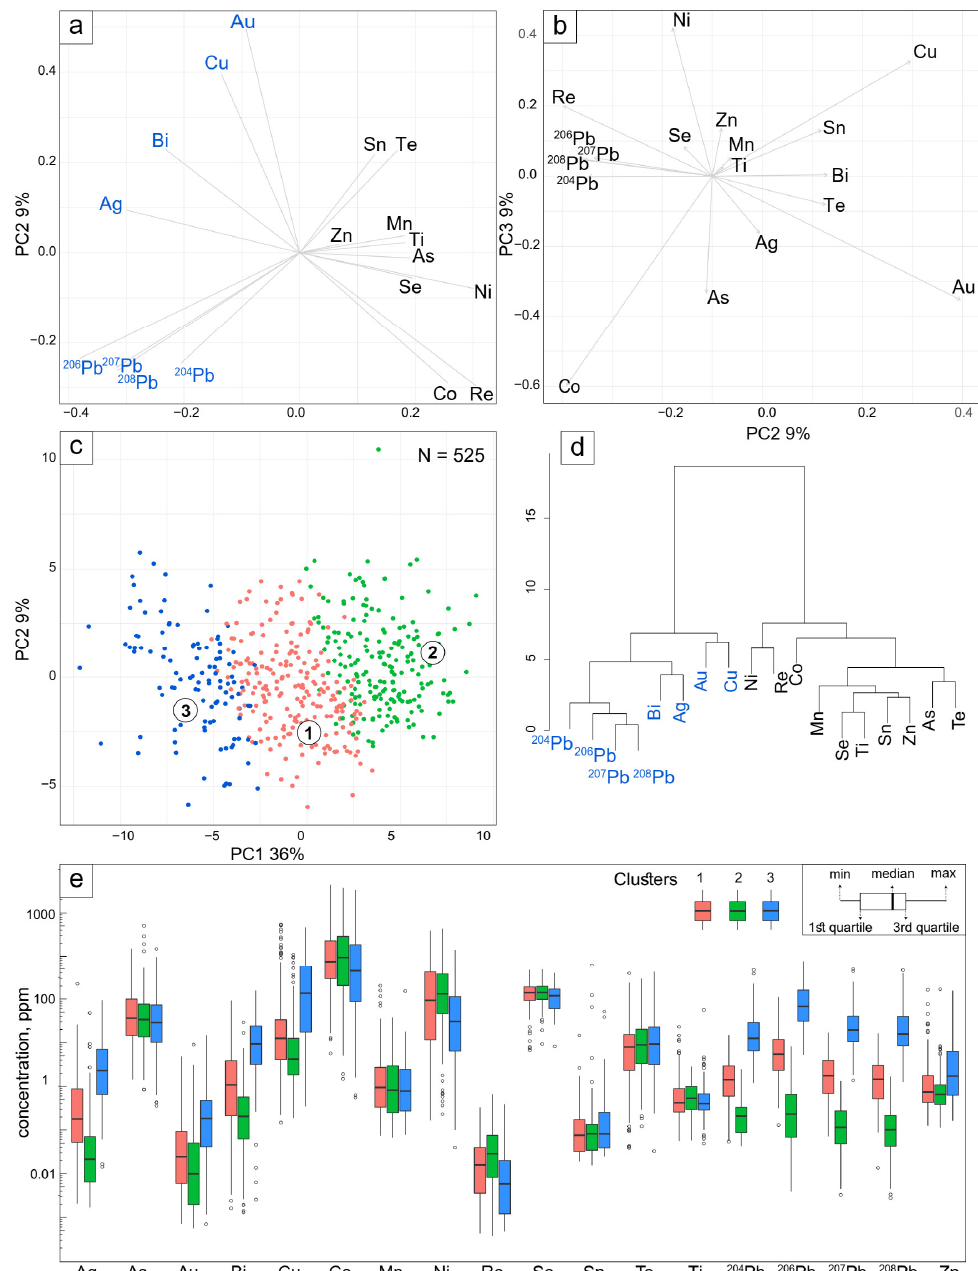
Figure 5. Principal component scores and loadings of centred log-ratio-transformed N = 525 data. The projection of PC1 versus PC2 ( a ) and PC2 versus PC3 ( b ) shows loadings of the elements. Principal component scores are shown on the PC1 versus PC2 projection ( c ), on which each dot corresponds to an individual sample assigned to one of three clusters (Supplementary Material B). Hierarchical cluster dendrogram ( d ) showing the association among the 18 elements with the height being a dissimilarity measure calculated from the variation matrix using Euclidean metrics (Table 4). ( e ) Box and whisker plot showing a range of concentrations for elements within each cluster. Note the correspondence among Cluster 3 and the Pb isotopes and Bi.